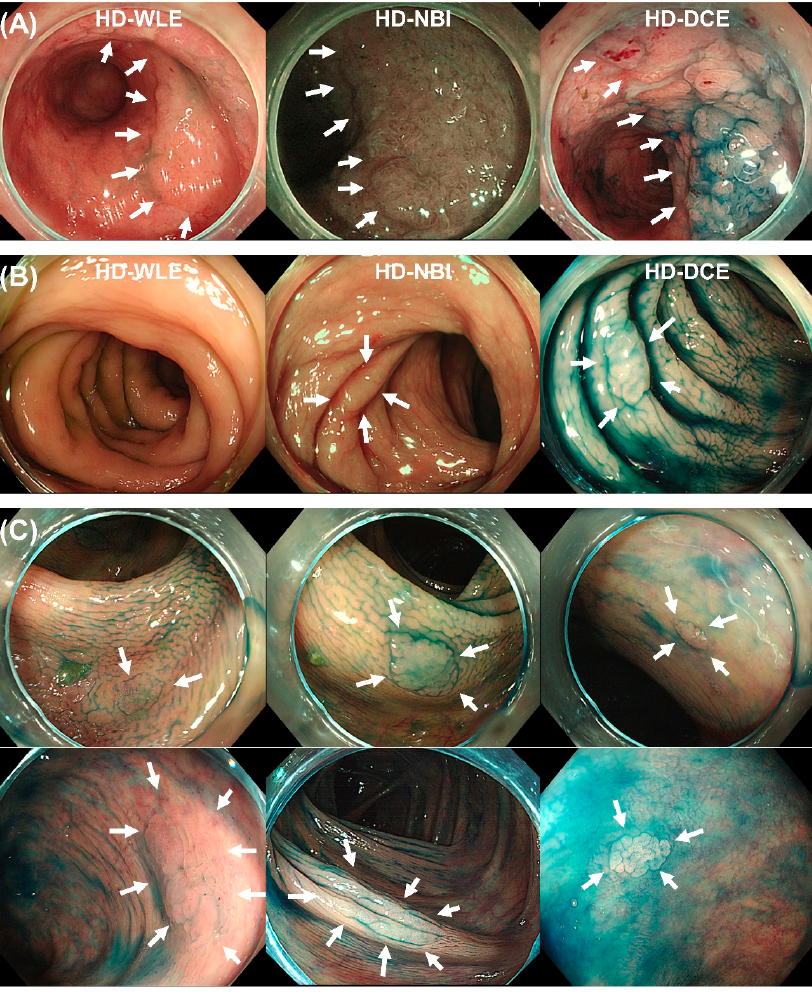
Figure 3. Sessile serrated adenomas/polyps detected by high-definition white-light endoscopy (HD-WLE), high-definition narrow-band imaging (HD-NBI), and high-definition dye spray chromoendoscopy (HD-DCE). ( A ) Sessile serrated adenoma/polyp detected in HD-WLE, ( B ) sessile serrated adenoma/polyp detected in HD-NBI, and ( C ) sessile serrated adenoma/polyp detected in HD-DCE. HD-WLE, high-definition white-light endoscopy; HD-NBI, high-definition narrow-band imaging; HD-DCE, high-definition dye spray chromoendoscopy. The total number of non-dysplastic lesions was 40, of which 21 (52.5%), 6 (15.0%), and 13 (32.5%) were detected by HD-WLE, HD-NBI, and HD-DCE, respectively (Table 2). About half of the non-dysplastic lesions were detected by HD-NBI and HD-DCE. The spo- radic lesions that developed in the colonic area without UC involvement included one adenoma, one SSA/P, and eight non-dysplastic lesions. In this study, sporadic lesions were excluded from the analysis due to their lack of association with colitis.